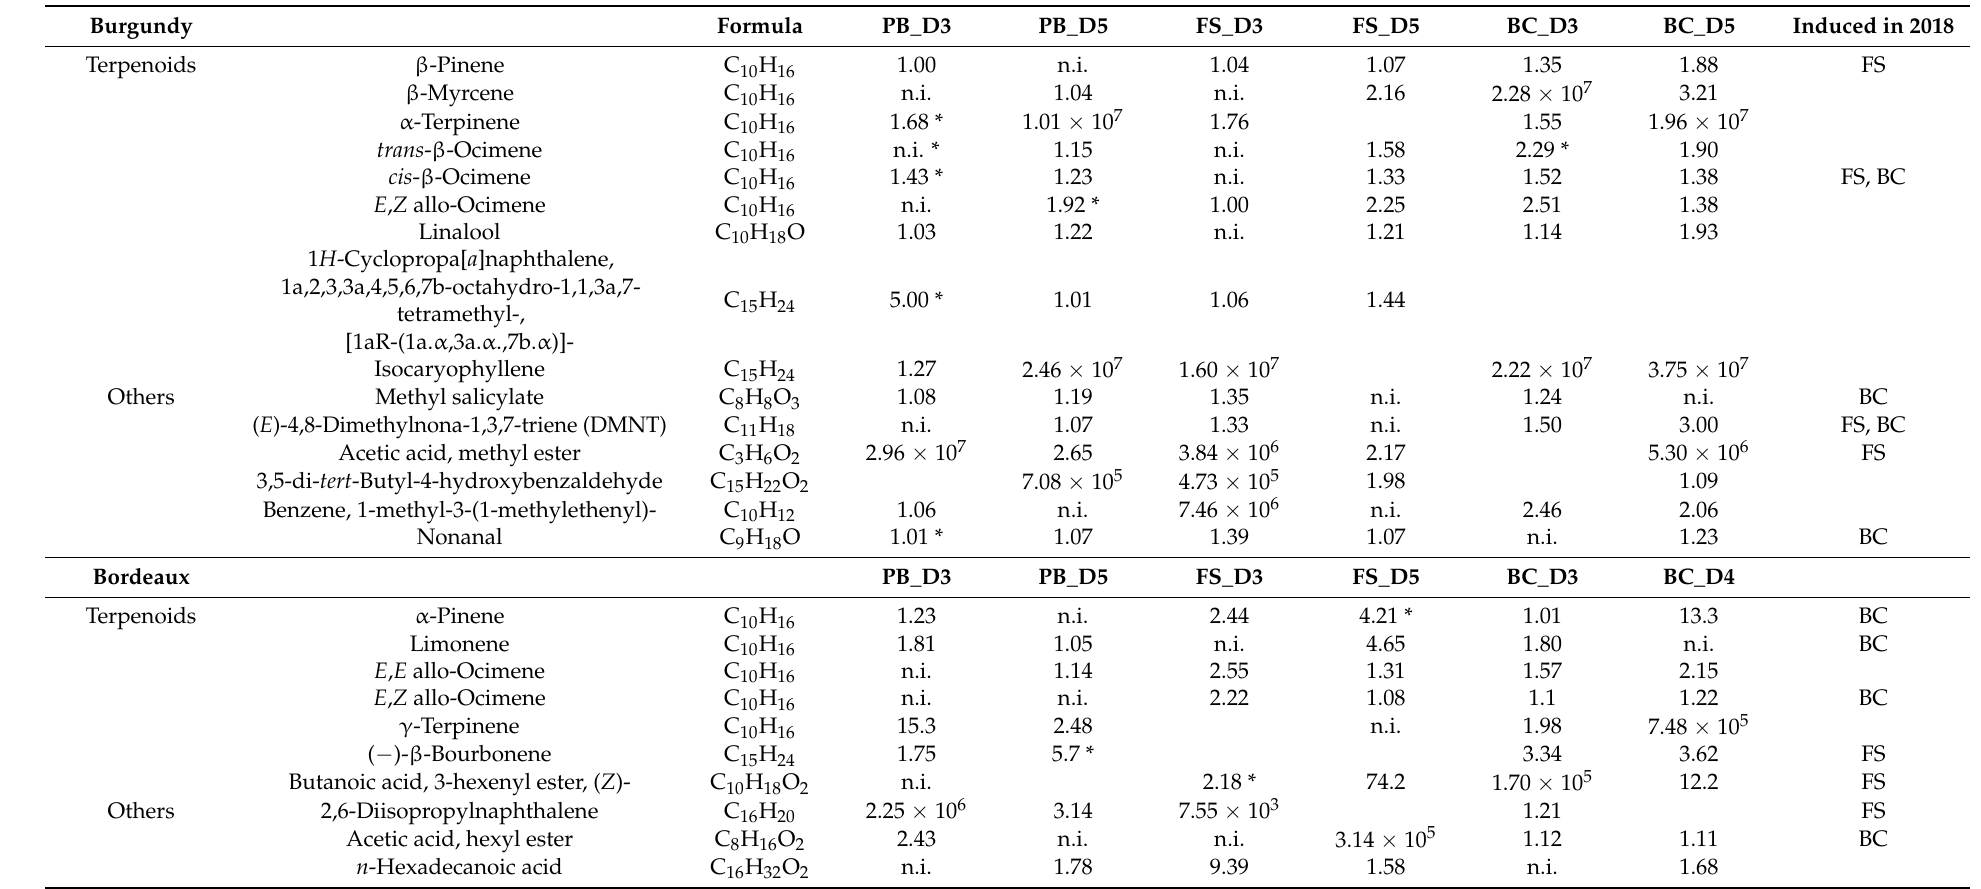
Table 2. Bastid ® -induced VOCs. Bastid ® -induced VOCs were selected over three phenological stages and two time points (BAG mode), in the Burgundy and Bordeaux vineyards. VOCs were retained when fold change (FC) > 1 at least 4 times out of the 6 time point datasets (ca. > 50% of the collected samples). *: Significant three- and five-days post treatment (D3 and D5). Phenological stages are indicated in the last column when VOCs were induced in the same vineyard in 2018-BAG (FC >